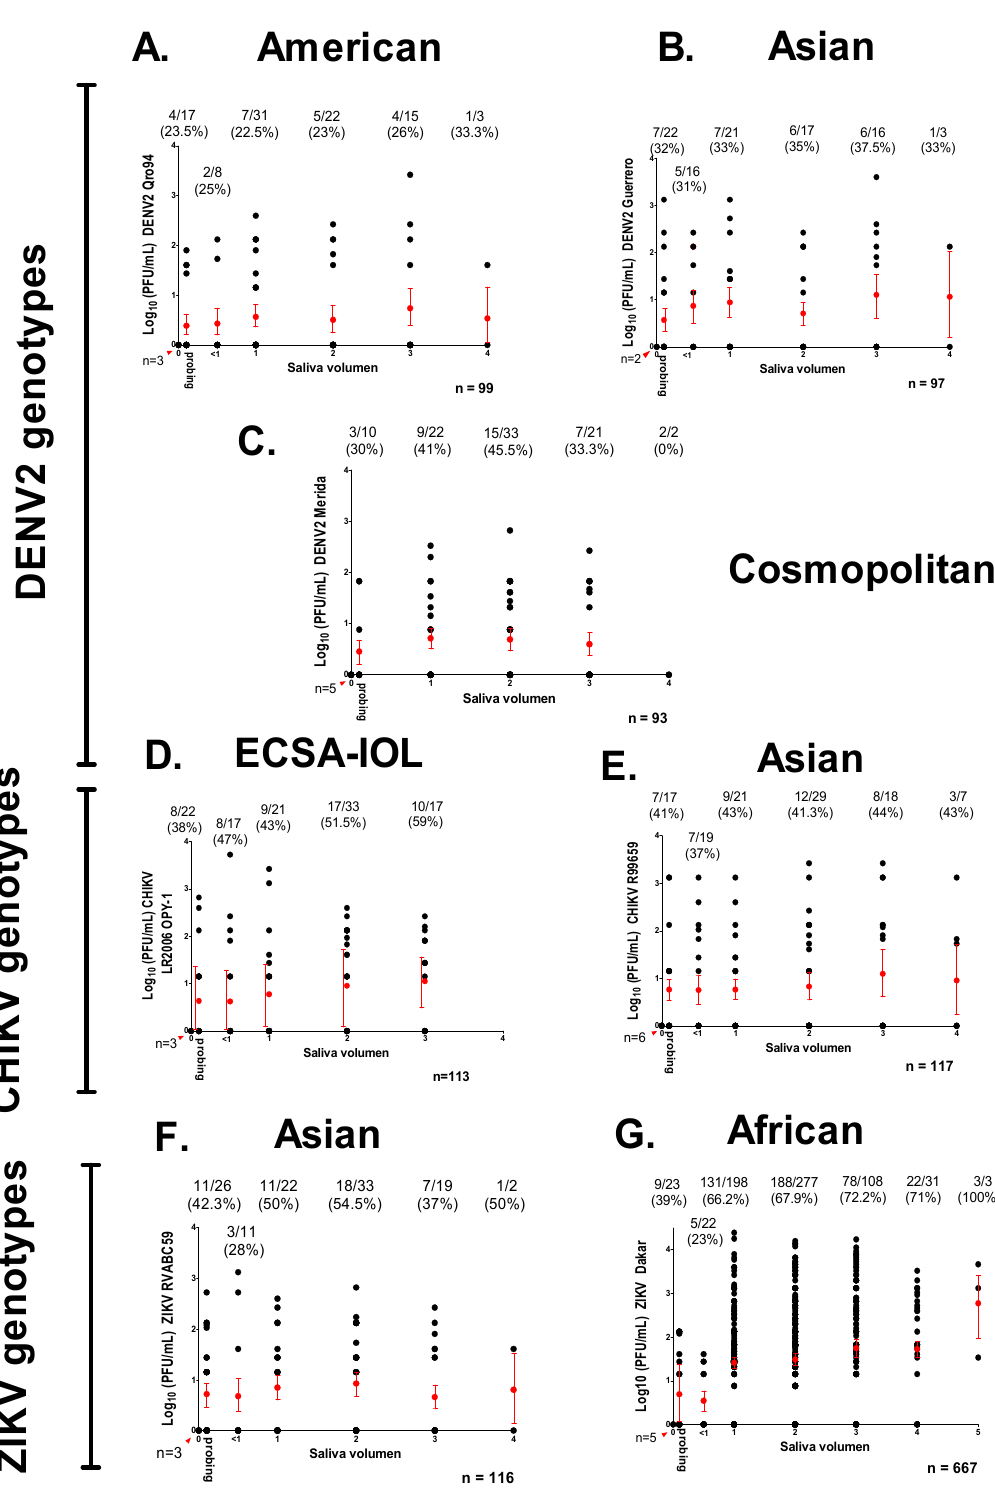
Figure 9. Correlation between virus titer log 10 (PFU/mL) per saliva and volume of saliva for the seven virus strains. Each column of points arising from the X-axis represents a volume of saliva assigned. In each column, the distribution of individual saliva titers appears as black circles, also the number of positive saliva/total number of saliva per volume and prevalence is in parenthesis. Mean titer values and their 95% confidence intervals are displayed in red. Red arrow indicates non-salivated samples ( n = 5). Total number of saliva samples tested and p value per virus strain are indicated. ( A ) DENV2 American genotype, ( B ) DENV2 Asian genotype, ( C ) DENV2 Cosmopolitan genotype, ( D ) CHIKV ESCA-IOL genotype, ( E ) CHIKV Asian genotype, ( F ) ZIKV Asian genotype, and ( G ) ZIKV African